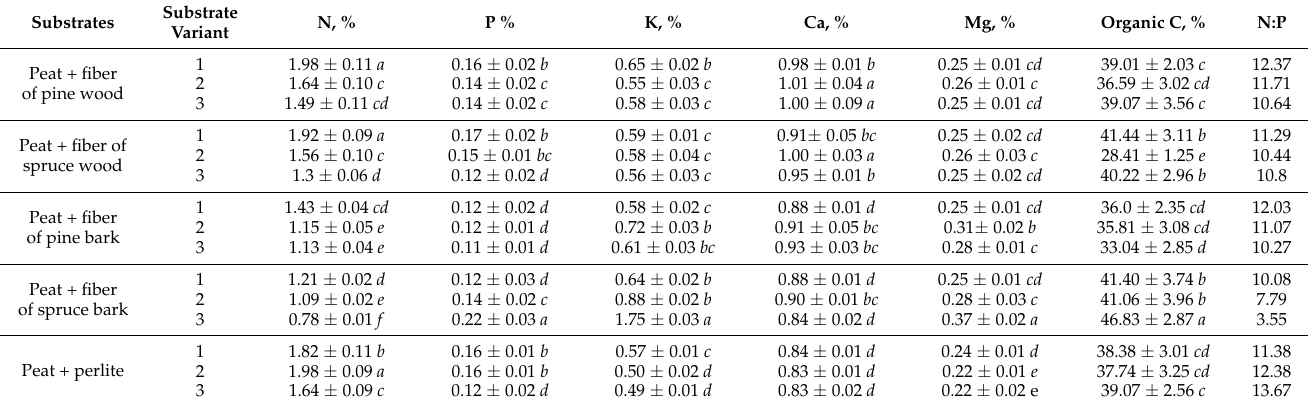
Table 6. Content of extractable macronutrients and organic carbon in the leaves of blueberry saplings according to the different additions of fiber and